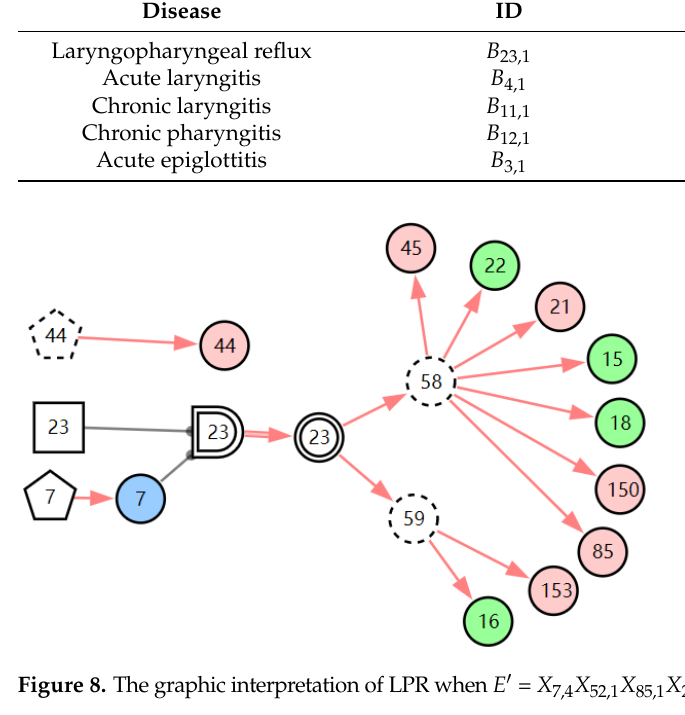
7,4 X 52,1 X 85,1 X 21,1 X 15,1 X 45,1 X 44,1 X 150,1 X 5,1 X 153,1 .